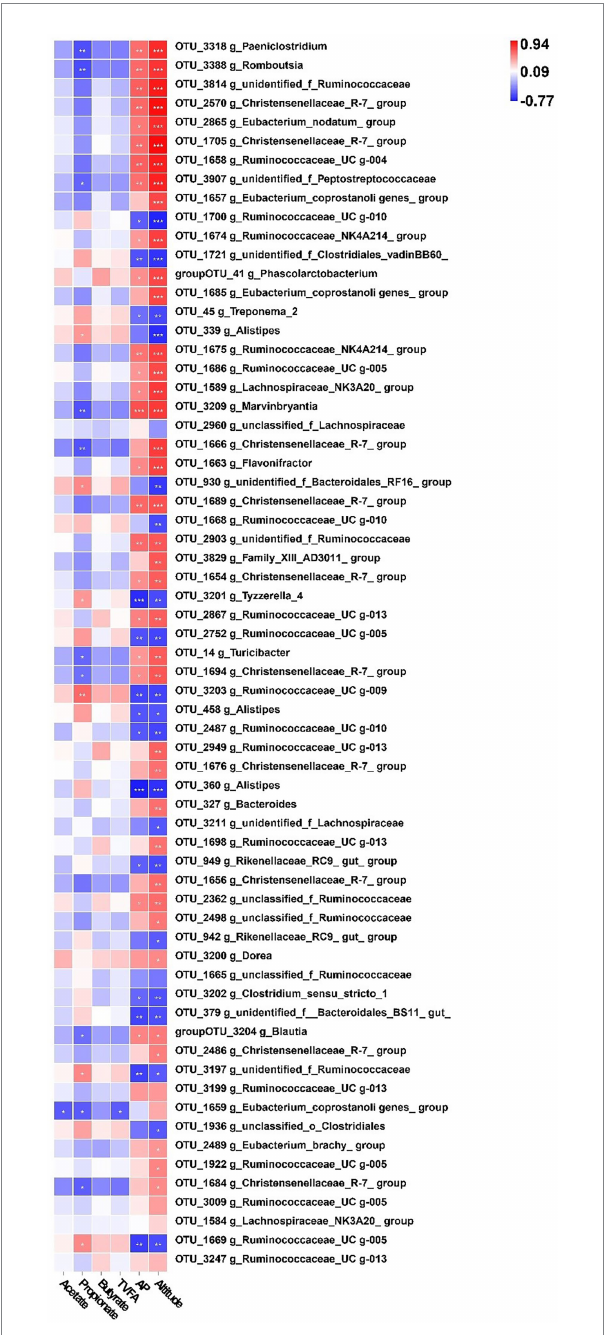
FIGURE 2 Correlation analysis of gut bacteria. (A) Heatmap of core operational taxonomic units (OTUs) (relative abundance >0.01% and p < 0.05 in all samples) significantly associated with metabolite production and fecal fermentative parameters in low-altitude (LA) and high-altitude (HA) Sanhe heifers, as determined by Spearman’s correlation analysis. *0.01 < p < 0.05, **0.001 < p < 0.01, *** p ≤ 0.001. (B) Interaction among OTUs with relative abundances > 0.01% and p < 0.05. The red and blue colors represent positive and negative correlations, respectively. The size and color of the circle represent the relative abundance of the OTUs and the genus to which they belong,